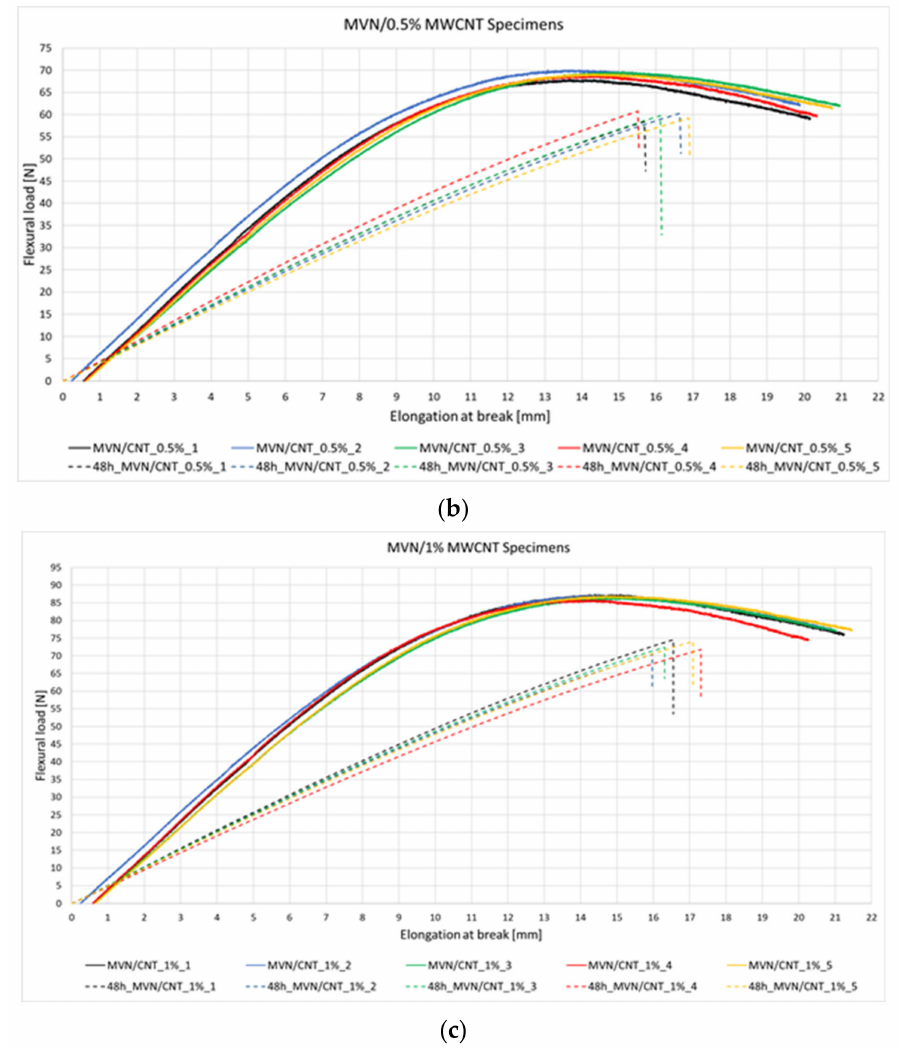
Figure 11. Flexural test results for the specimens containing the ( a ) self-healing system, ( b ) self-healing system and 0.5% MWCNT and ( c ) self-healing system and 1% MWCNT after first and second